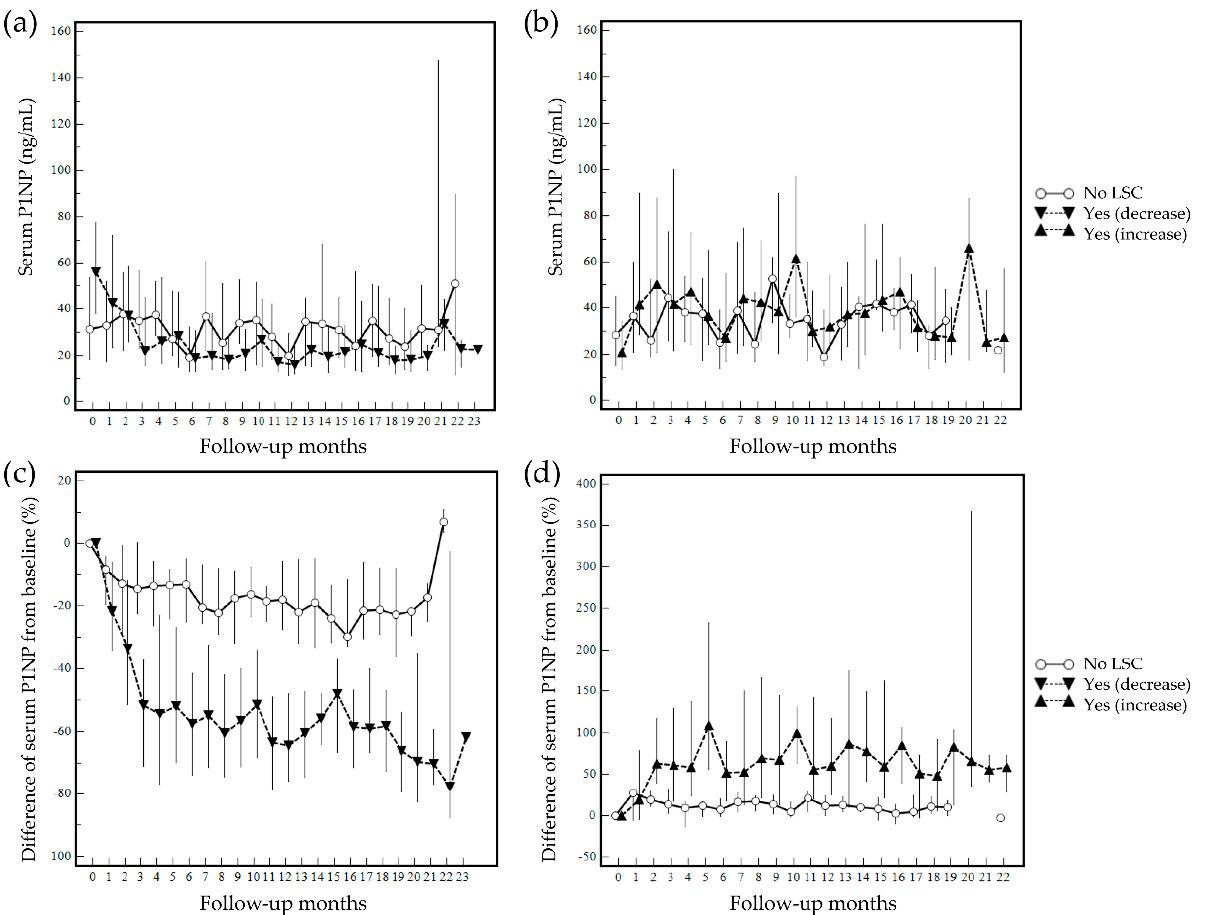
Figure 5. Changes in serum P1NP at follow-up (median serum P1NP level by follow-up month is presented and grouped based on least significant changes (LSC) ≥ 40% from baseline): ( a ) quantitative changes in patients who experienced a decrease in P1NP during follow-up; ( b ) quantitative changes in patients who experienced an increase in P1NP during follow-up; ( c ) %difference from baseline in patients who experienced a decrease in P1NP during follow-up; ( d ) %difference from baseline in patients who experienced an increase in P1NP during follow-up. ‘No’ represents no achievement of least significant changes, and ‘Yes’ represents an achievement of least significant